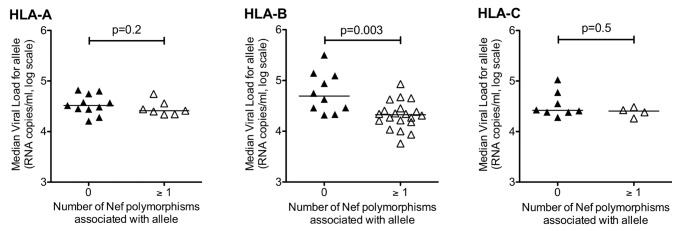
Relationship between number of HLA associations with Nef sequence polymorphisms and median viral load for subjects expressing that allele, for HLA-A, -B and -C alleles.Data from lineage-corrected analysis of 739 C-clade Nef sequences. P-values by Mann–Whitney U test.